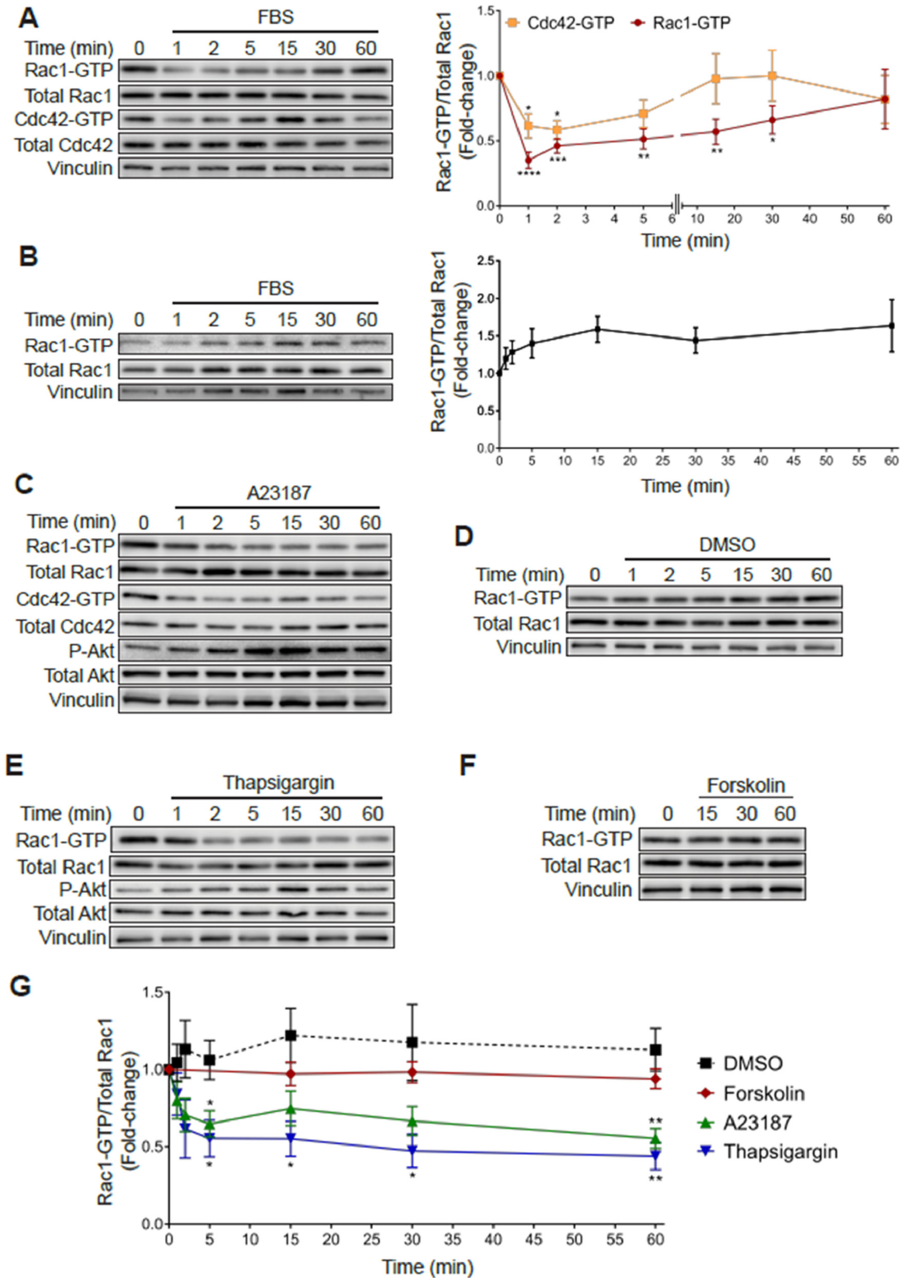
Figure 6. Increased Rac1-GTP levels in PC3 cells are sensitive to elevations in intracellular calcium. ( A ) Serum starved PC3 cells were stimulated with FBS (10%) for the indicated time and a PBD pull-down assay was performed to determine Rac1-GTP and Cdc42-GTP levels. ( B ) Similar experiments were carried out in LNCaP cells. For ( A , B ) Left panels , representative experiments. Right panels , densitometric analysis of Rac1-GTP levels normalized to total Rac1, and Cdc42-GTP levels normalized to total Cdc42. ( C – F ) Serum starved PC3 cells were treated with DMSO (0.1%), A23187 (2 μ M), thapsigargin (1 μ M) or forskolin (1 μ M) for the indicated times, and PBD pull assays were performed to determine Rac1-GTP and Cdc42-GTP levels. ( C – F ) Representative experiments are shown for ( C ) DMSO, ( D ) A23187, ( E ) thapsigargin and ( F ) forskolin treatment. ( G ) Densitometric analysis of Rac1-GTP levels normalized to total Rac1. Results, relative to the unstimulated time point, are expressed as the mean ± S.E. ( n = 3–7). * p < 0.05; ** p < 0.01; *** p < 0.001; **** p <